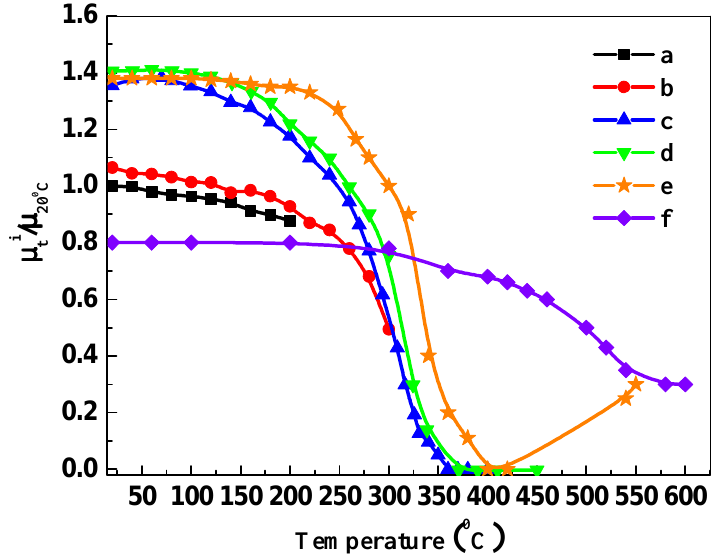
Figure 2. The temperature dependence of change in normalized magnetic permeability of AMA Cu Nb Si B : a) first heating up to 200ºC (i=1), b) second heating up to 300ºC (i=2), c) third Fe 73.5 1 3 15.5 7 heating up to 400ºC (i=3), d) forth heating up to 450ºC (i=4), e) fifth heating up to 550ºC (i=5) and f) sixth heating up to 600ºC (i=6) in